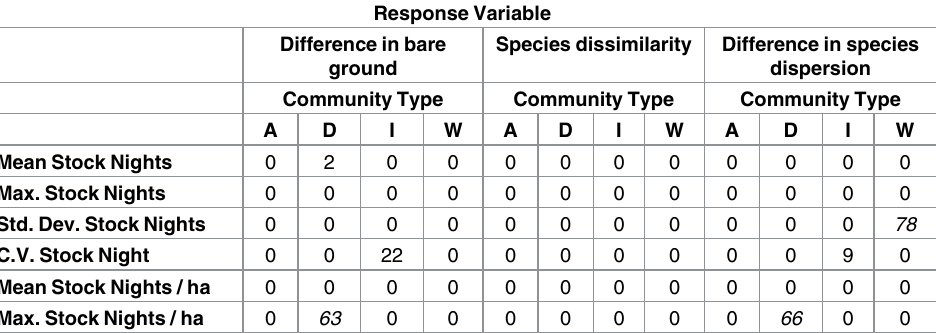
Table 2. Classification and Regression Tree (CART) model contributions (%) of specific stock use metrics. Individualmodelsare indicatedby vegetationcommunity types and responsevariable combinations. Vegetation Communitytypes: A = All; D = Dry; I = Intermediate; W = Wet. Instances where a Stock Use Metric contributed to more than 50% of a CART model are